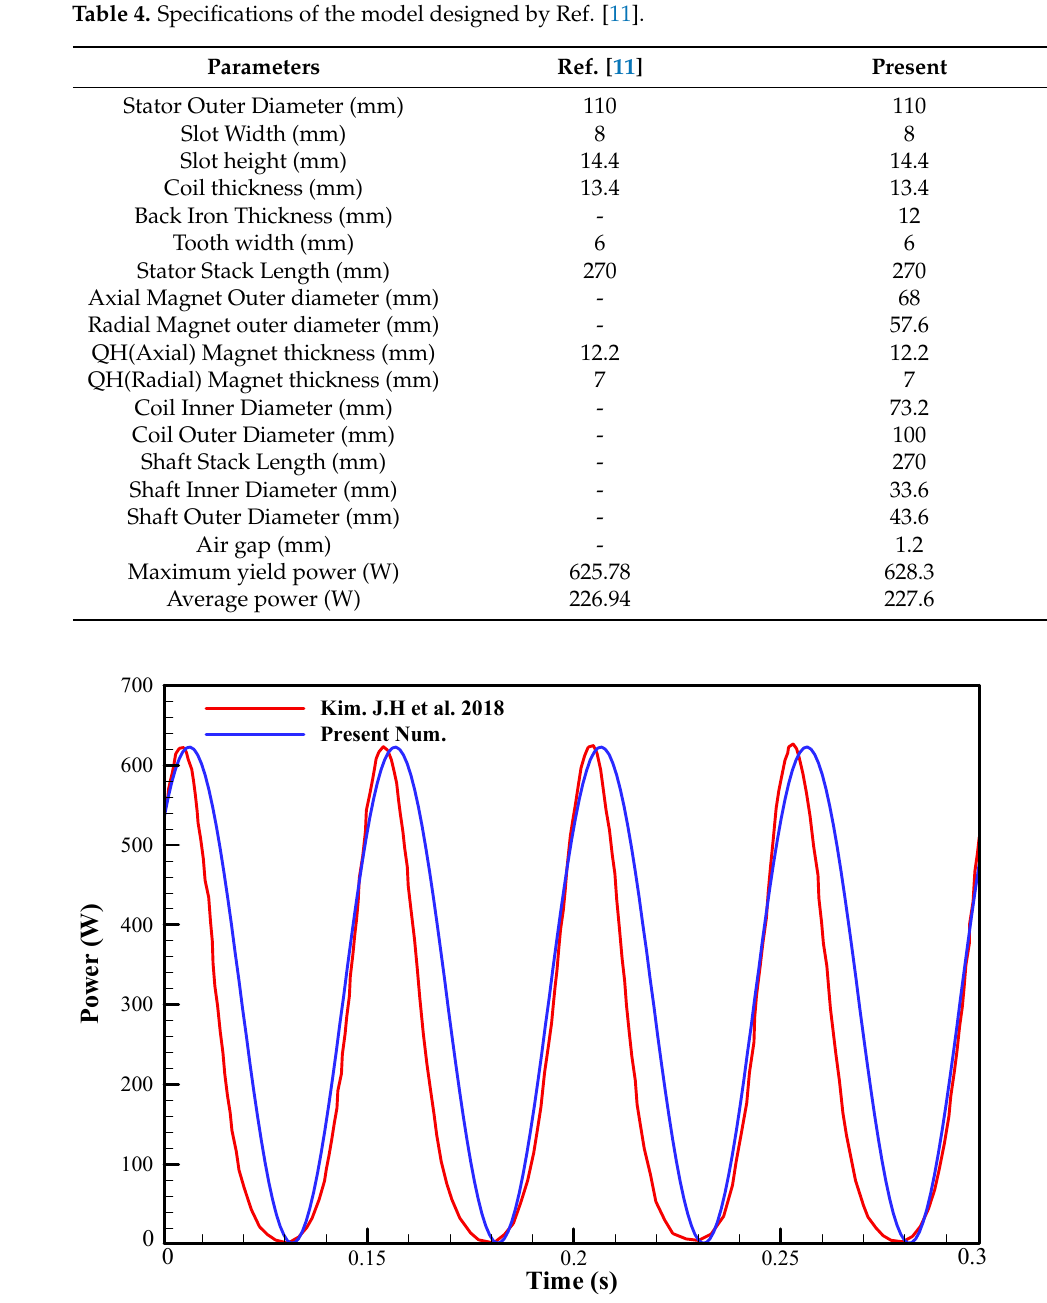
Figure 8. Variation of power with time in the present numerical model and that in Ref. [11].